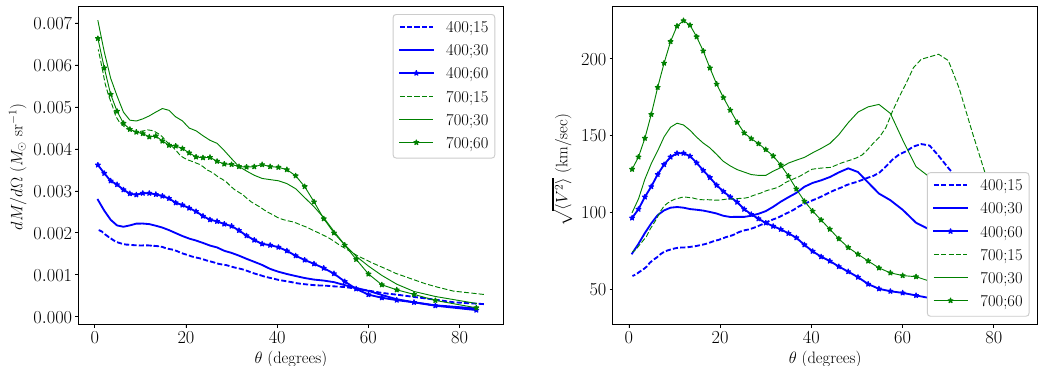
Figure 3. Left panel : The mass lost from the grid per unit solid angle as a function of the angle from the equatorial plane, for six different simulations with spiralling-in orbits. The secondary star launches jets while it spirals-in the asymptotic giant branch star envelope on its equator with a tangential Keplerian velocity and with a constant inward radial velocity. The initial orbital period equals to 198.4 days. The simulations stop after 595 days. The three first digits in the legend represent the jets velocity in kilometres per second while the two last digits represent the jets half-opening angle in degrees. The equator is at θ = 0 and the poles are at θ = 90. Simulations: 400;30, 400;60, 700;30, 700;60 are from [28], while simulations 400;15 and 700;15 are new. The amount of mass lost is that from the two hemispheres combined. In all six cases the jets inject mass at a rate of ˙ M j = 0.001 M Right panel : The average speed of the outflow as a function of the angle from the equatorial plane of these six simulations.